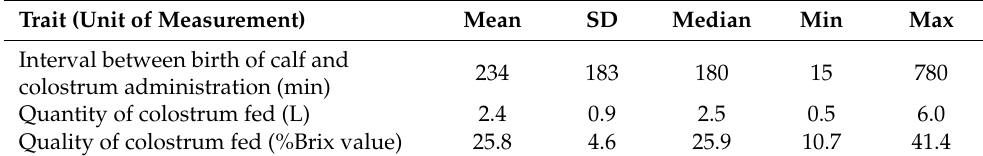
Table 1. Descriptive statistics of colostrum administration